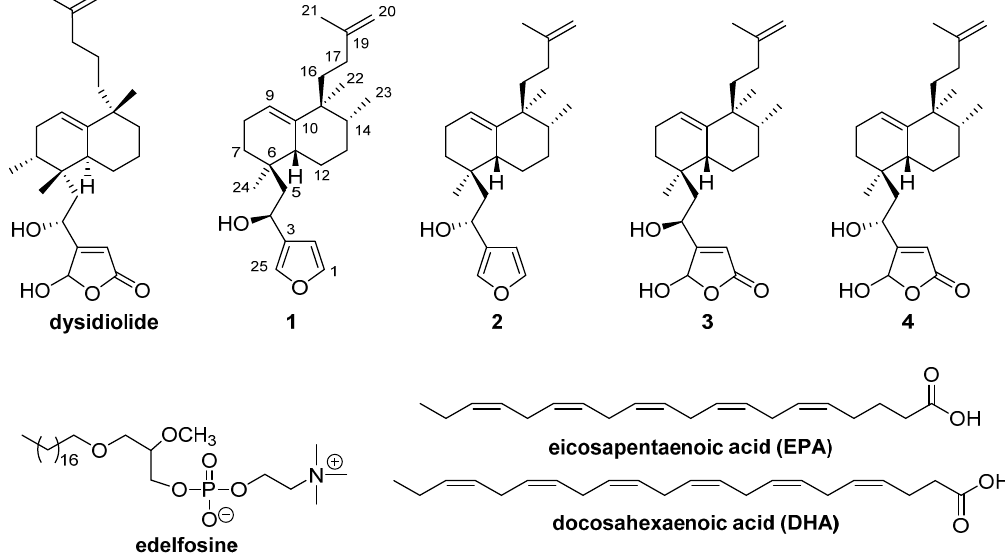
Figure 1. Dysidiolide, edelfosine, PUFAs and sesterterpenoid compounds used for bioconjugation.